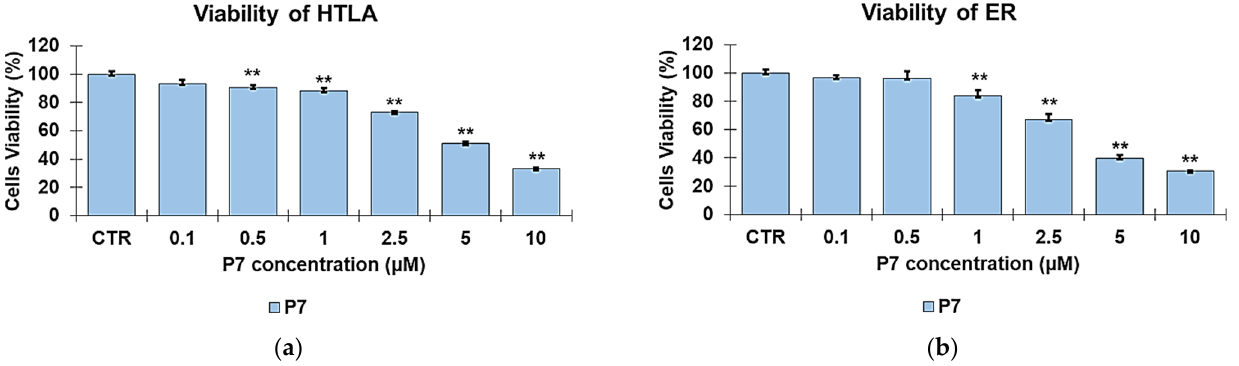
Figure 7. Cell viability was evaluated by CellTiter 96 ® AQueous One Solution Cell Proliferation Assay in HTLA-230 (HTLA, a ) and HTLA-ER (ER, b ) cells exposed to increasing concentration of P7 (0 – 10 µM) for 24 h. Bar graphs summarize quantitative data of the means ± SEM of three independent experiments.** p < 0.01 vs. Ctr cells.